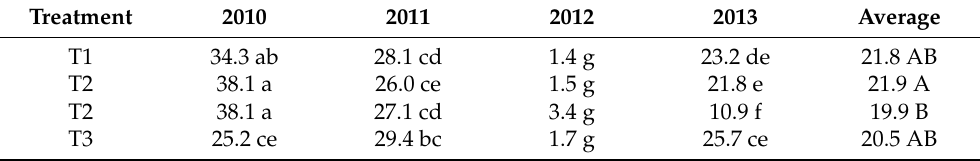
Table 3. Influence of the treatment on olive yield per tree between 2010 and 2013 (kg tree − 1 ).